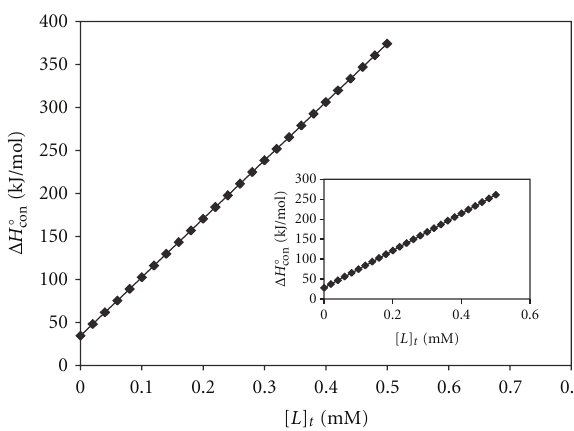
Figure 4: The molar enthalpies of CT-DNA denaturation in the interaction with [Pt(bpy)(Oct-dtc)]NO 3 and the inset for [Pd(bpy)(Oct-dtc)]NO 3 complexes in the range of 300 K to 310K. (Table 1). The above thermodynamic parameters agree